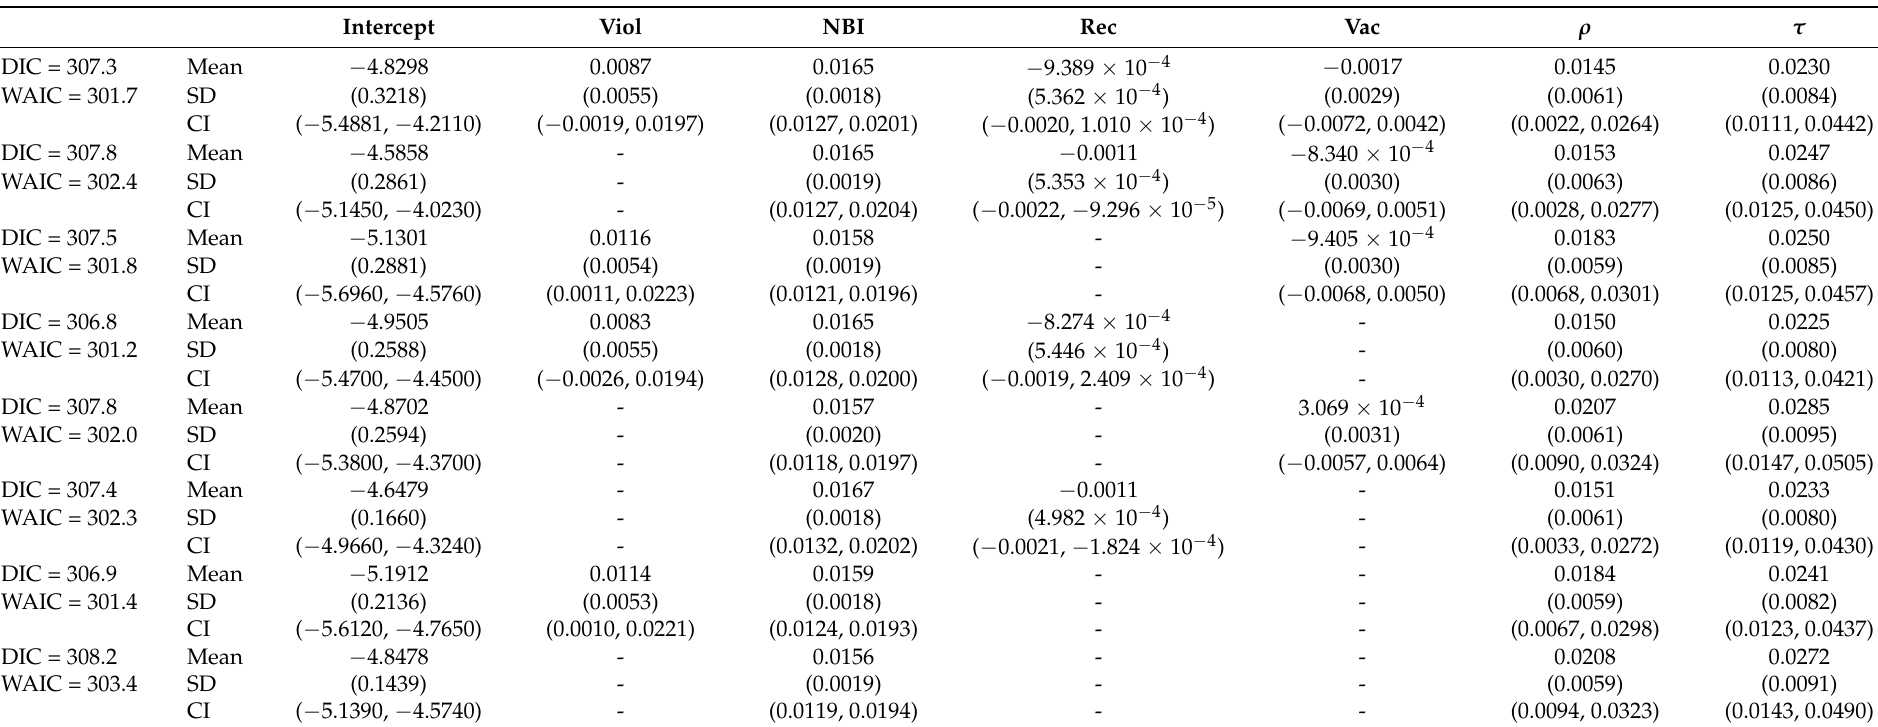
Table 3. Parameter estimates, standard deviations and 95% credible intervals in parenthesis for the parameters in the models, and Deviance Information Criterion (DIC) and Watanabe- Akaike Information Criterion (WAIC) values for some of the reduced versions of the spatial conditional normal Poisson model fitted to the Colombian infant mortality rates data